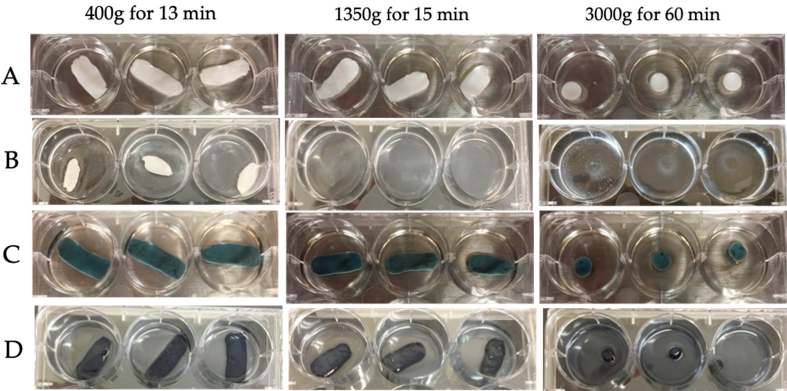
Figure 3. Genipin crosslinking of hybrid membranes increases biological stability following trypsin incubation. Columns indicate membranes generated by three di ff erent centrifugation protocols.